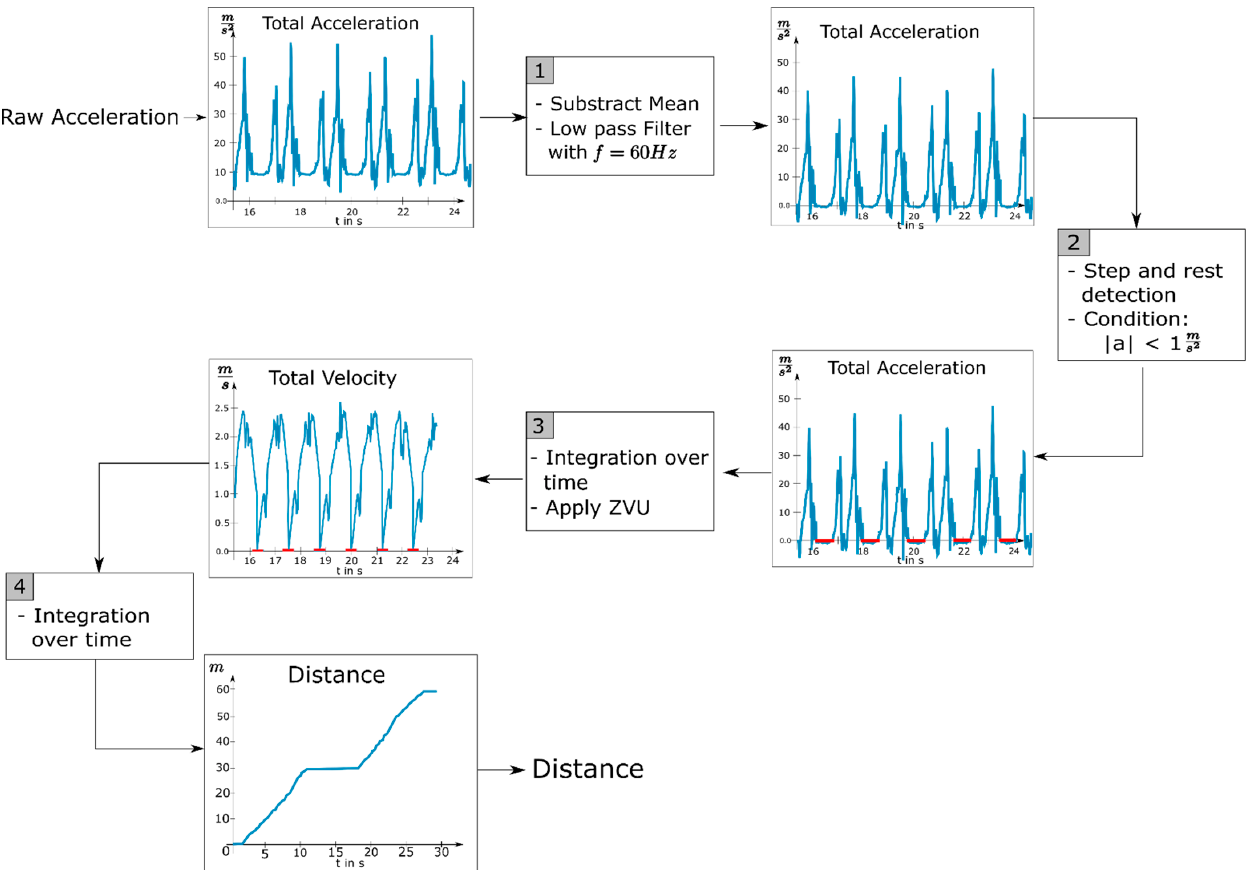
Figure 2. Flowchart for determining the distance walked; ZVU = zero velocity updates.